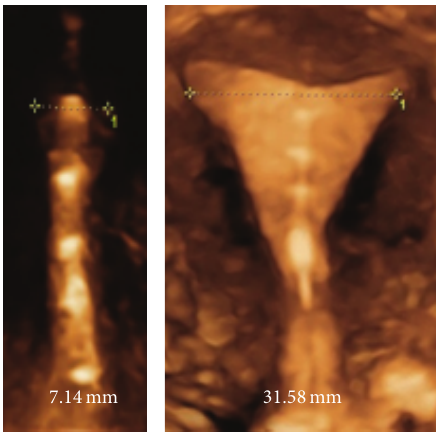
Figure 3: 3D illuatration in two women fitted with a frameless IUD showing the disparity in width of the IUD which varies in these women between 7.14 and 31.58